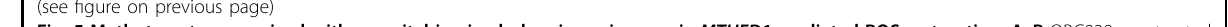
expression of MTHFD1 , the key enzyme in folate meta- bolism. Under the catalysis of MTHFD1 during the transversion of the isoforms of THF, NADPH was pro- duced as a by-product and imbalanced the cellular redox